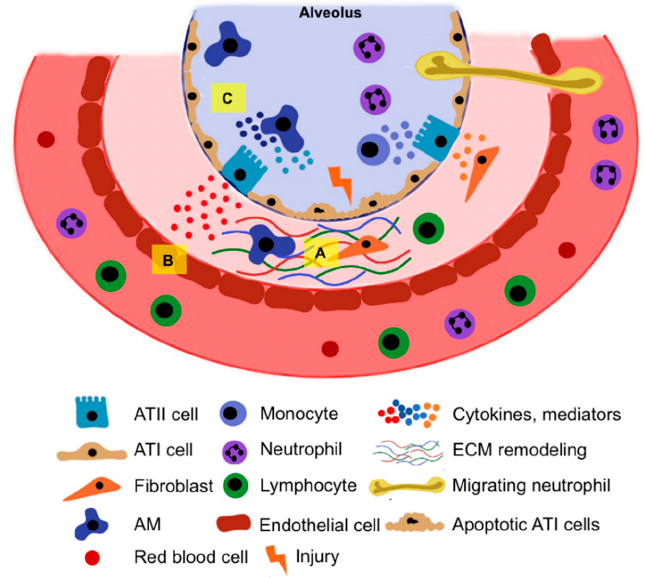
Figure 1. Various cell types are part of the ATII cell niche, providing a specific microenvironment to support alveolar re-epithelialization after injury. ( A ) Mesenchyme, including fibroblasts, extracellular matrix (ECM), and pericytes around endothelium and alveoli, can sense microenvironmental changes and mechanical stress and interact with alveolar epithelium, contributing to tissue remodeling. ( B ) Activated endothelial cells proliferate and regulate alveolar epithelial cell repair after injury to maintain alveolar–capillary function and integrity. ( C ) Immune cells are a component of the regenerative alveolar type II (ATII) cell niche. Alveolar macrophages (AM) are important in innate immunity, regulating adaptive immunity, and recruiting neutrophils and monocytes into the lungs. They defend against pathogens while supporting ATII cell proliferation and differentiation to alveolar type I (ATI) cells. Together, various reciprocal interactions, transcription factors, mediators, and signaling pathways among different cell types orchestrate complex lung repair and